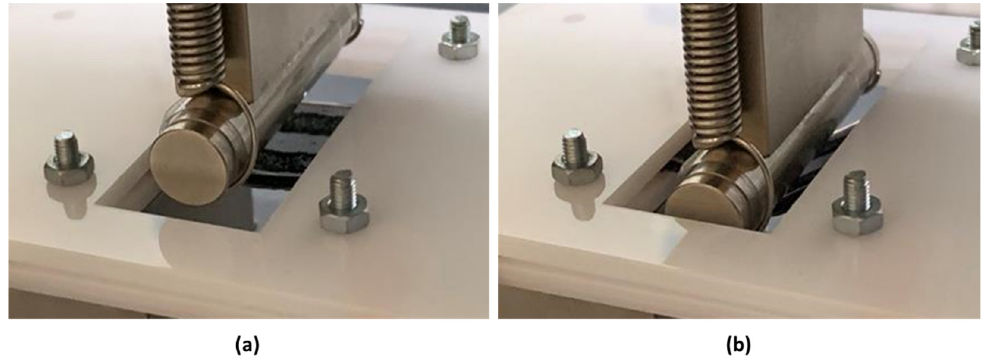
Figure 3. Bending tests with an applied force of 6.6 N, ( a ) press and ( b ) release motion. The piezoresistive sensors were characterised using a Keithley DMM7510 7½ Digital Multimeter, where both sample electrodes were connected to the multimeter terminals.